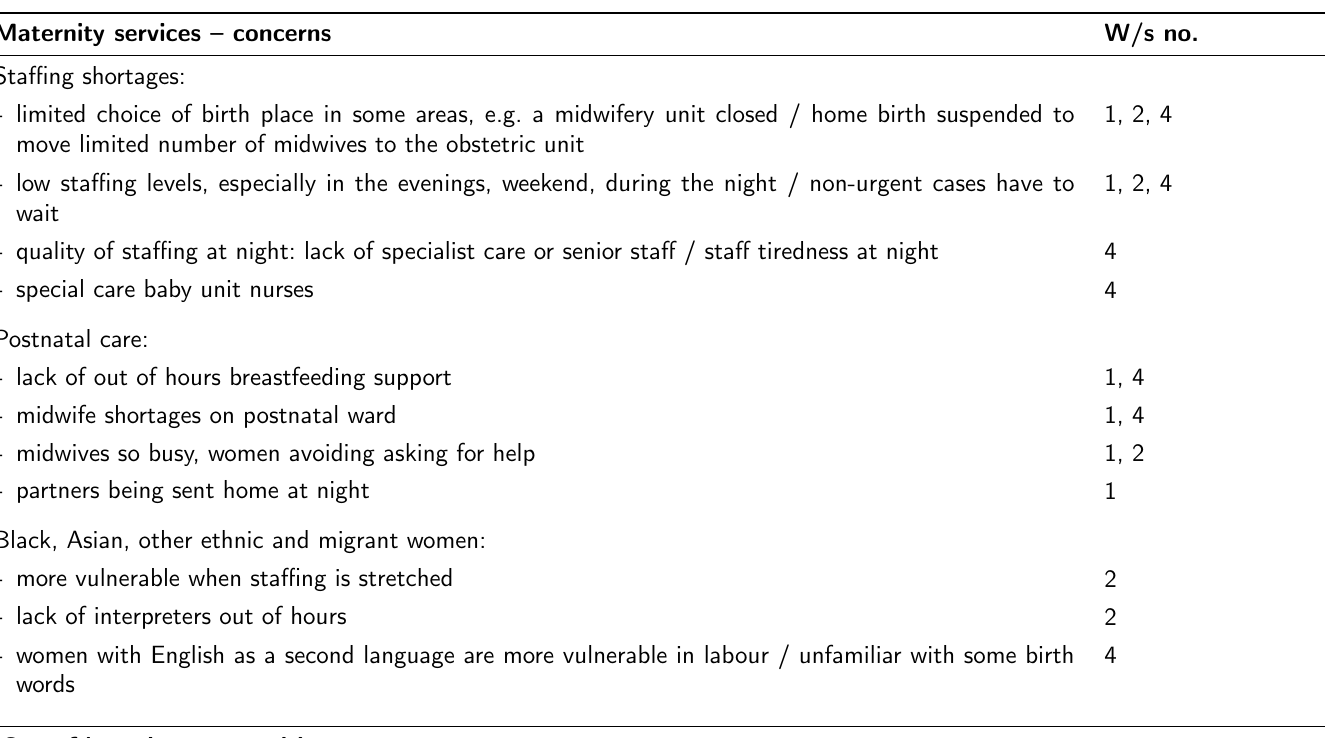
Table 1: a) Examples of maternity services concerns, benefits of ‘out of hours’ care, and b) research questions at the engagement